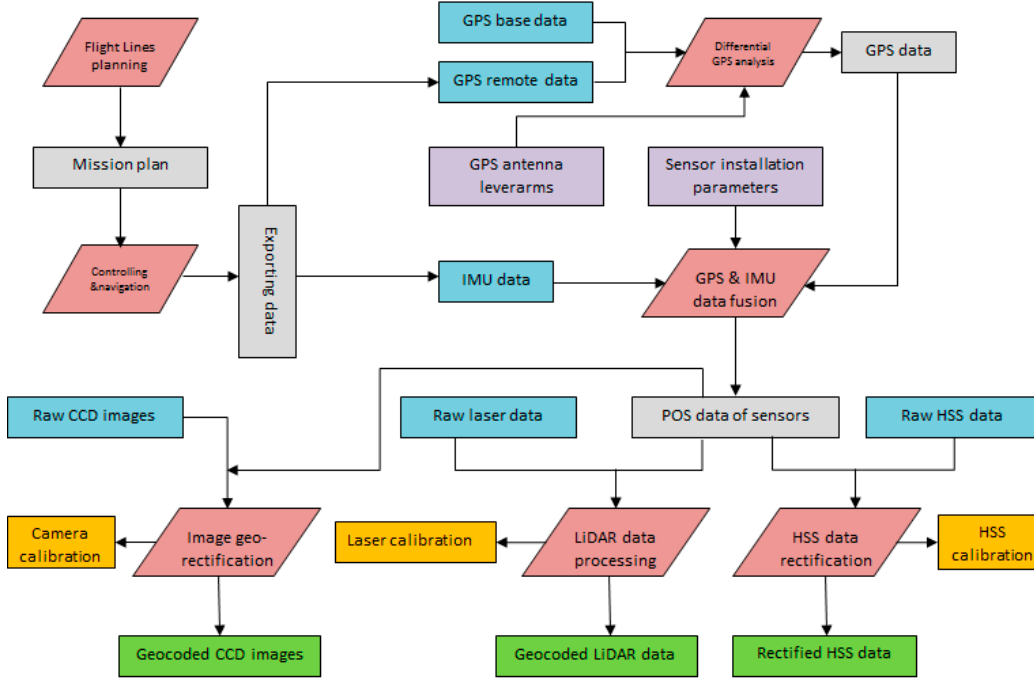
Figure 4. The data flow of LiCHy airborne observation system.